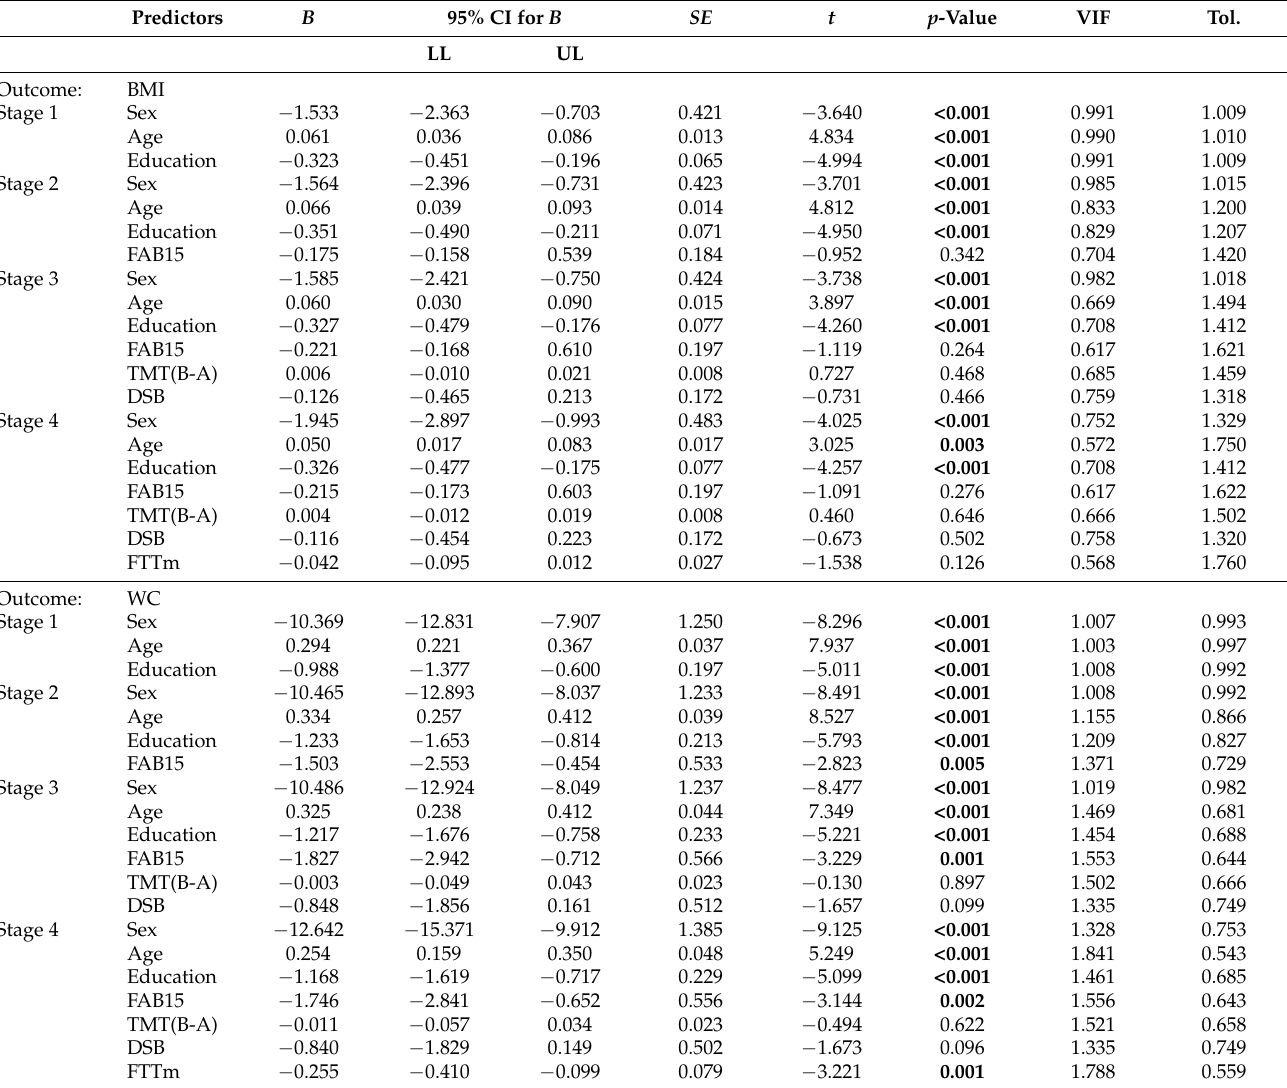
Table 3. Results of the hierarchical regression analysis on BMI and